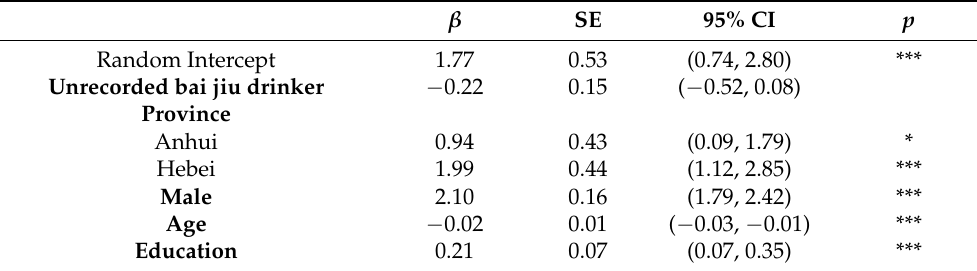
Table 5. Two-level linear regression model of the effect of unrecorded bai jiu drinker and province on the quantity of bai jiu consumed on memorable occasions.